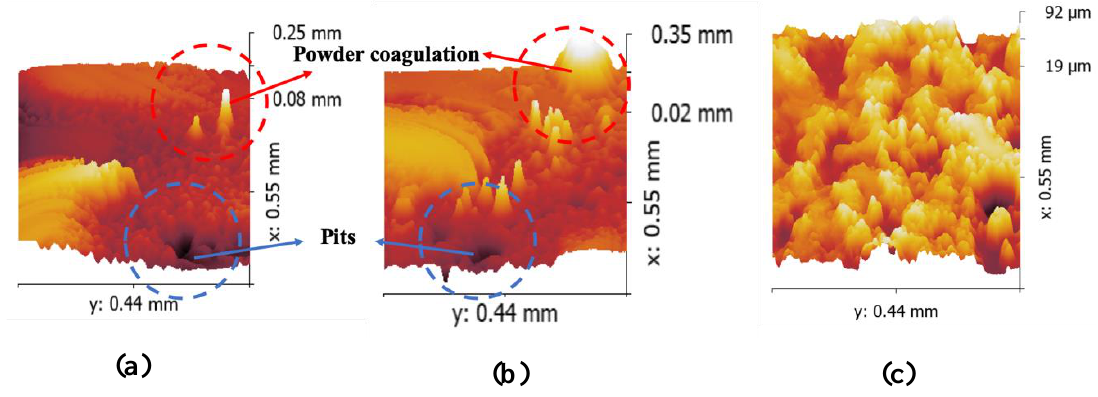
Figure 6. Side surface morphologies: Specimens 1 (printed using Z-shape scan strategy vertical to the inner structure) and 3 (printed using square-framed scan strategy) (( a ) and ( b ), respectively); and Specimen 2 ( c ) (printed using Z-shape scan strategy along the inner structure).